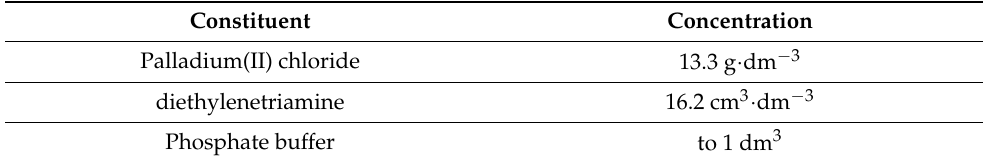
Table 3. The chemical composition of the Pd plating bath.